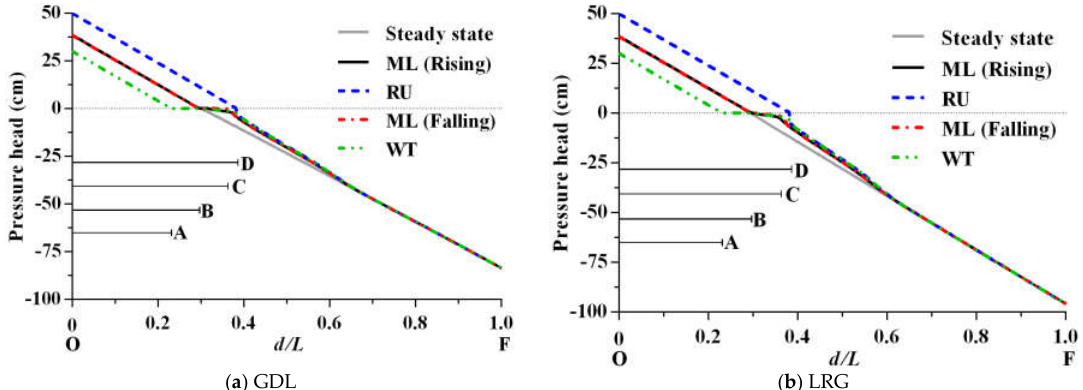
Figure 3. Pressure head distributions on the lakeshore (the OF line, Figure 1) during no-wave conditions and at different stages of a wave cycle for the GDL ( a ) and LRG ( b ) cases. See Figure 1 for locations of points A, B, C, D, F, and O. Horizontal solid lines represent relative distances of points A, B, C, and D from point O. The gray horizontal line represents a zero pressure head. The ratio d / L represents a relative distance of a point on the OF line from point O or a relative height above point O ( L represents the length or height of the OF line).